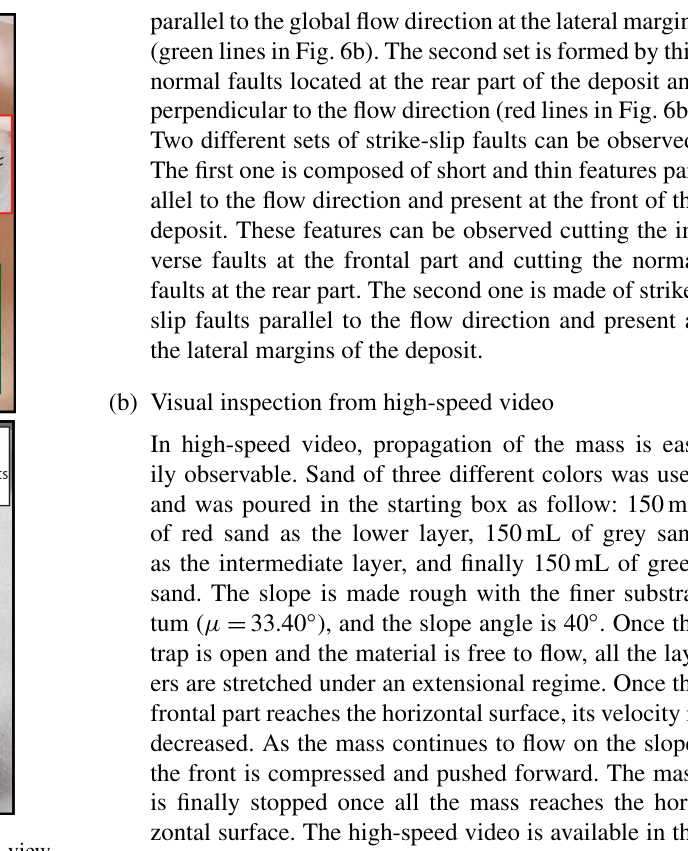
Figure 6. (a) Analog deposit (F120, aluminum substratum), view from the top; (b) result visual inspection and feature mapping ob- served on the deposit